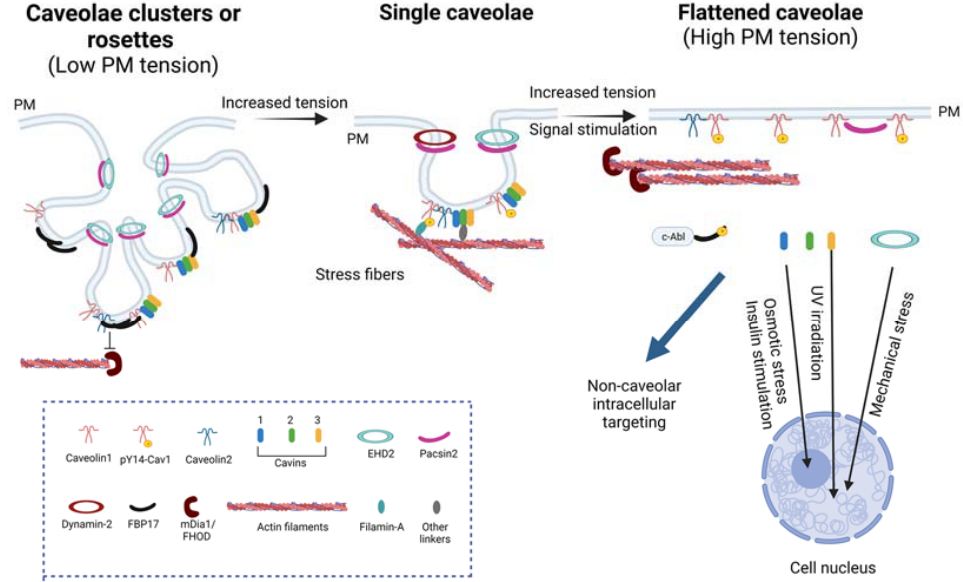
Figure 2. Caveolae composition and changes upon mechanical and signaling challenges. Single caveolae are composed of caveolins, cavins, and accessory proteins, and they may associate with the actin cytoskeleton through Filamin-A and other unknown linkers. Upon mechanical forces or signal stimulation, caveolae can flatten and release some of their components for intracellular targeting, such as Cavin1, Cavin3, and EHD2. This also stimulates FBP17 phosphorylation by c-Abl and its dissociation. When PM tension is reduced, caveolae organize into rosettes that require FBP17, which inhibits formin mDia. Furthermore, Cav1 could be phosphorylated at Y14 in response to mechanical stimuli. Created with BioRender.com accessed on 1 March 2023.